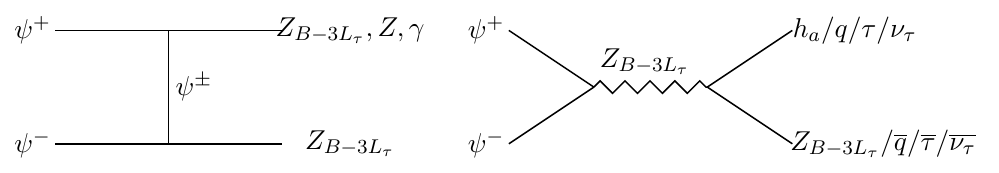
Figure 19 . Feynmann diagrams for co-annihilation processes of i ( i = 1 ; 2) with the charged component